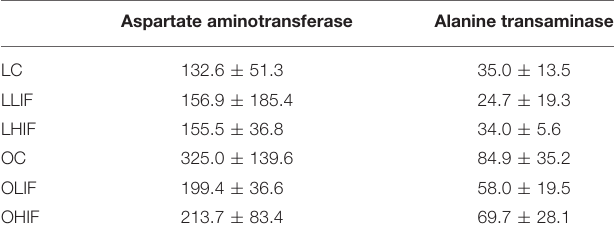
TABLE 4 | Mean ± standard deviation of aspartate aminotransferase (AST) and alanine transaminase (ALT) between lean and obese rats on low and high diet isoflavones.